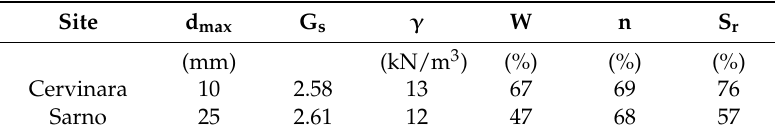
Figure 1. ( a ) Geological map of the Campania region and location of the two investigated deposits of Cervinara ( b ) and Sarno ( c ). Table 1. Physical characteristics of ash soils.